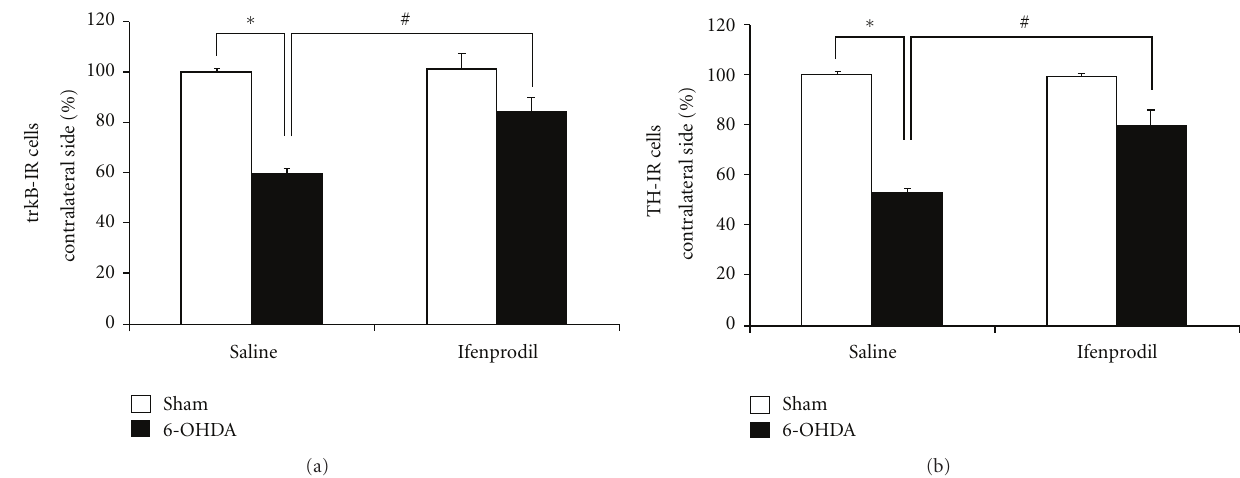
Figure 7: Ifenprodil, an antagonist of NR2B containing NMDA receptors, prevents the decrease in trkB-IR and TH-IR cells occurring in SNc 14 days after 6-OHDA intrastriatal injection. Positive cells for trkB and TH immunostaining in SNc were counted in coronal midbrain slices of treated rats as described in Section 2. Four groups of rats in each case (a) and (b) were pretreated with saline solution or Ifenprodil (5mg/kg, i.p.), 1 day before and 3, 5, and 7 days after unilateral 6-OHDA (black columns) or ascorbic acid (sham, white columns) intrastriatal administration. The IHC studies were performed 14 days after 6-OHDA or ascorbic acid injections. Results were expressed as a percentage of trkB-IR cells (a) or TH-IR cells (b) in the ipsilateral SNc compared with the contralateral side. (a) Number of cells with trkB-IR signals in sample areas per slice from contralateral SNc was equal to 365 . 1 ± 15 . 9, 381 . 0 ± 31 . 7, 412 . 7 ± 10 . 6, and 404 . 7 ± 15 . 9 cells/mm 2 in sham- saline, 6-OHDA-saline, sham-Ifenprodil, and 6-OHDA-Ifenprodil rats, respectively. (b) Number of TH-IR cells in sample areas per slice from contralateral SNc was equal to 404 . 8 ± 23 . 8, 357 . 1 ± 29 . 8, 386 . 9 ± 11 . 9, and 369 . 0 ± 6 . 0 cells/mm 2 in sham-saline, 6-OHDA-saline, sham- Ifenprodil, and 6-OHDA-Ifenprodil rats, respectively. The di ff erent experimental groups were compared by a Kruskal-Wallis nonparametric ANOVA, followed by a U -test. ∗ P < 0 . 05, when comparing saline-6-OHDA versus saline-sham rats. # P < 0 . 05 when comparing saline-6- OHDA versus Ifenprodil-6OHDA rats. n = 3 rats under each experimental